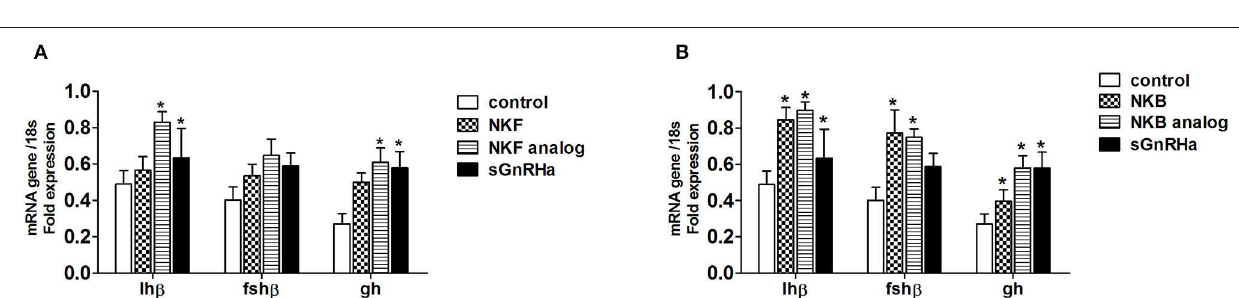
FIGURE 5 | In vivo effect of tilapia NKF (A) or NKB (B) and their analogs on gh , fsh and lh mRNA expression. Female tilapia were injected with native peptides, analogs (100 µ g/kg BW), or sGnRHa (10 µ g/kg BW) at time 0; saline-injected fish served as controls. Pituitary samples were collected 24h post injection for RNA extraction. Columns marked by asterisks significantly differ from basal: * p < 0.05; (one-way ANOVA followed by